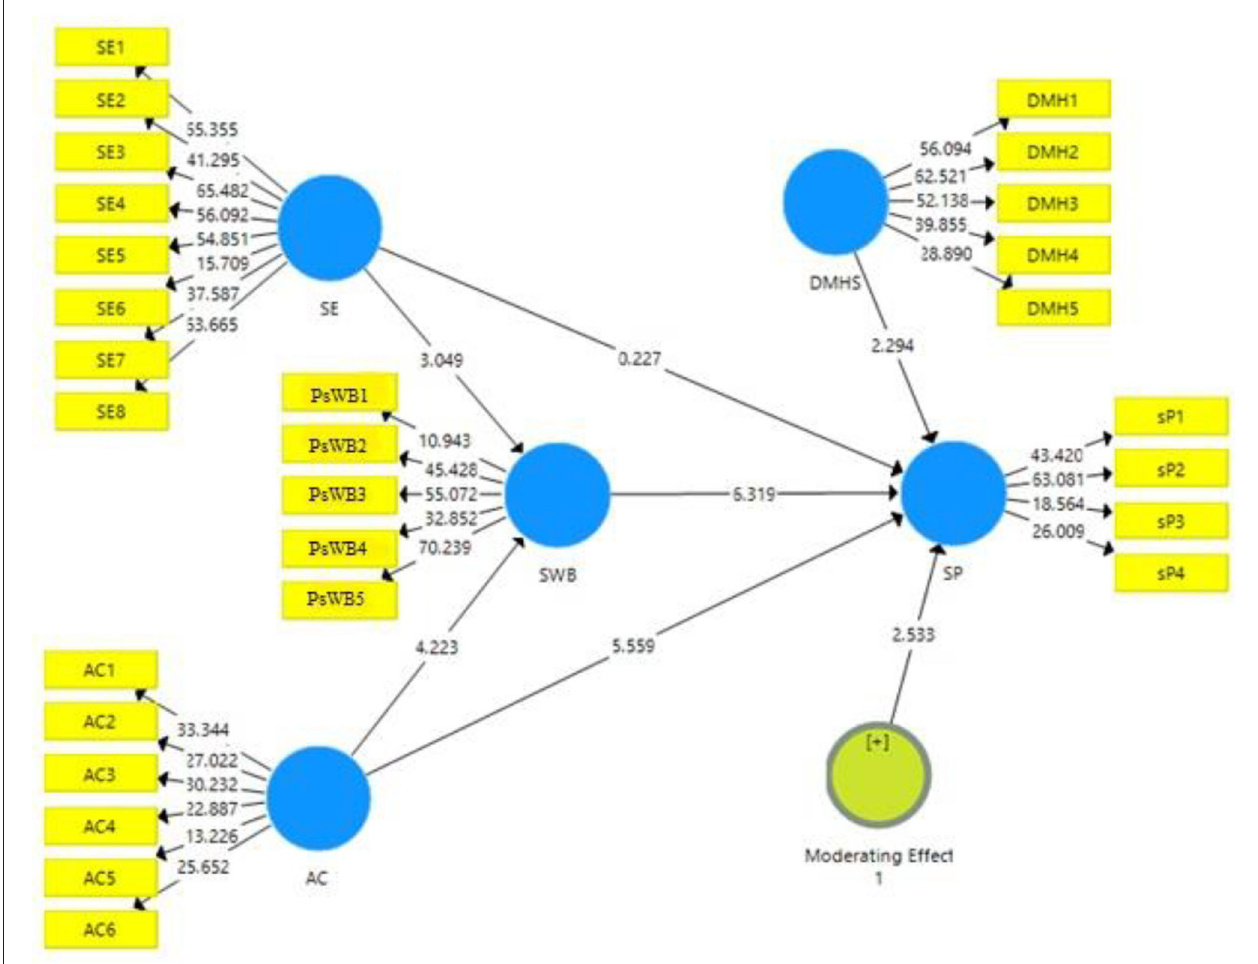
FIGURE 3 | Structural model. AC, affective commitment; DMHS, digital mental health services; SE, self efficacy; SP, student performance; PsWB, psychological wellbeing.